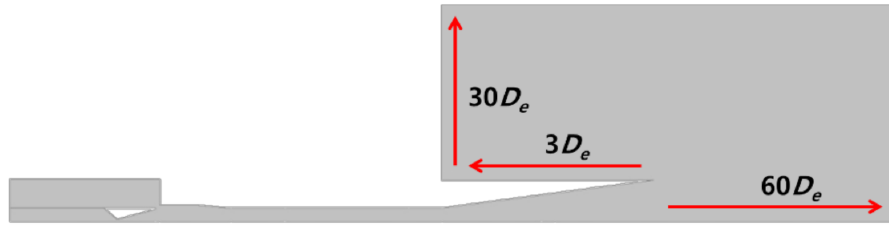
Figure 2. The atmospheric domain added for better flow simulation near the diffuser